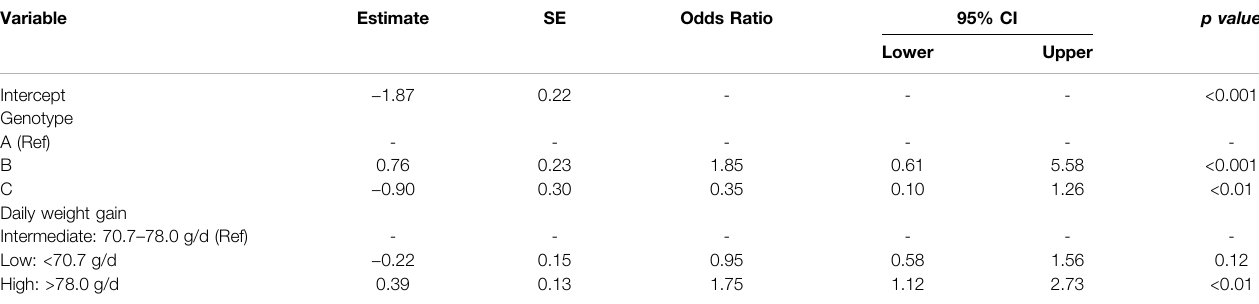
TABLE 5 | Factors in fl uencing wooden breast occurrence in male broiler chickens and extracted by forward selection in the multivariate logistic regression analysis. Variable Estimate SE Odds Ratio 95% CI p value Lower Upper Intercept − 1.87 0.22 - - - <